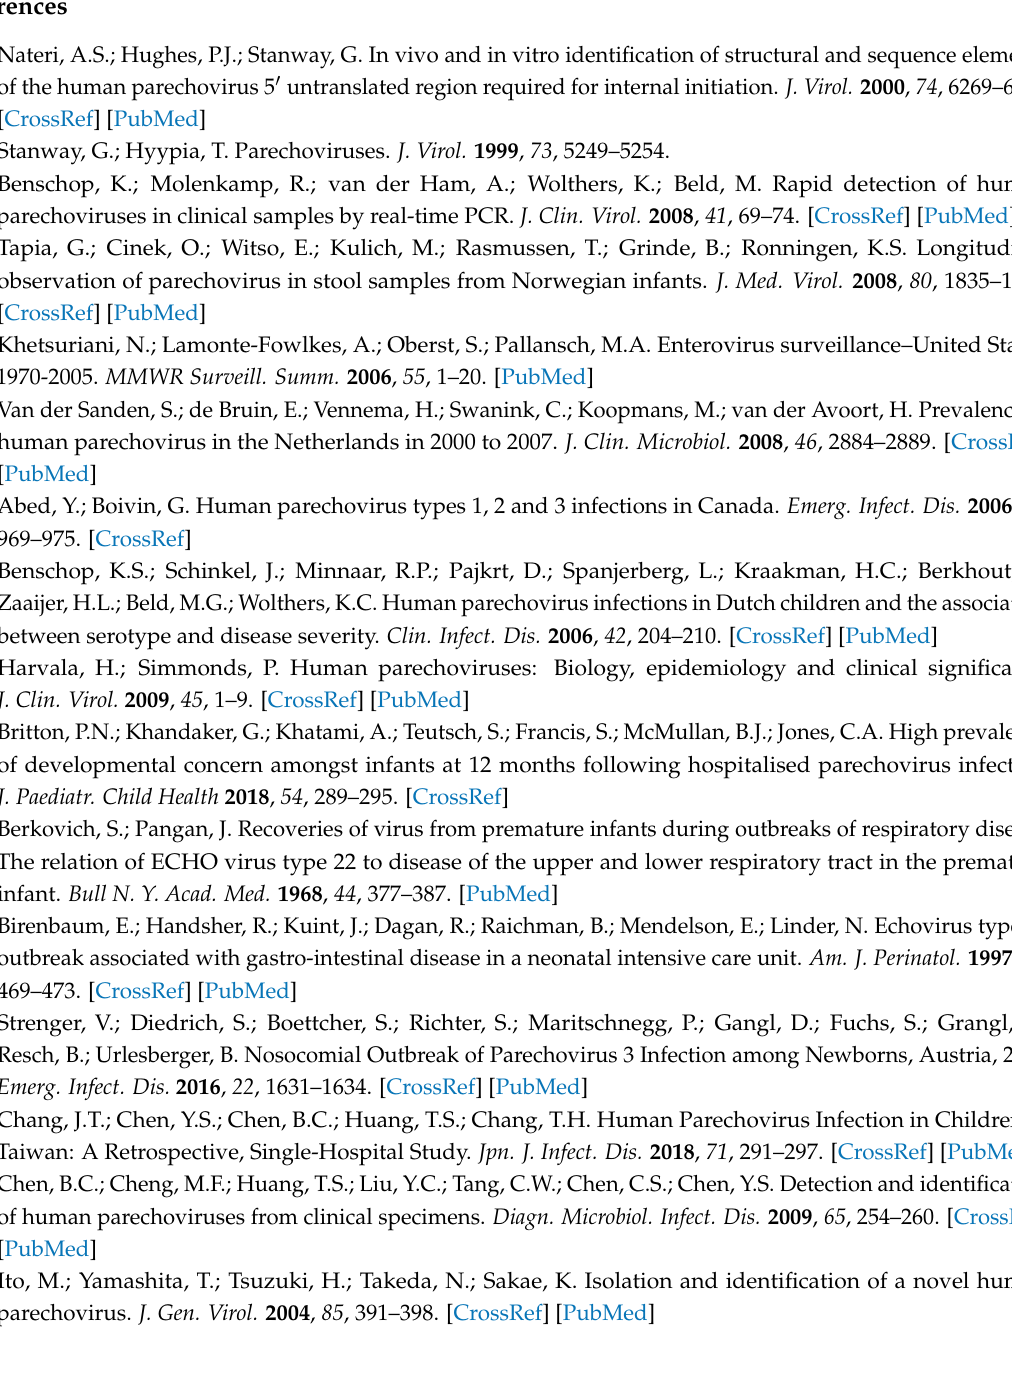
s1, Figure S1: The full immunoblots images of Figure 3A. Figure S2: The full immunoblots images of Figure